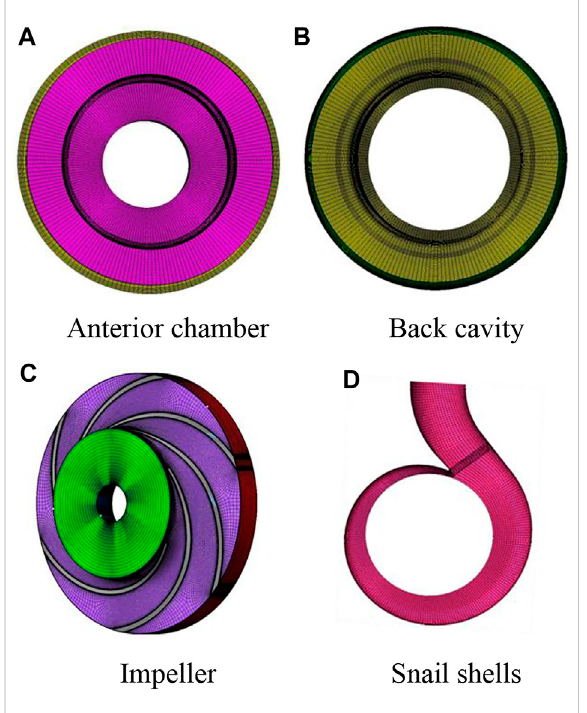
FIGURE 2 Centrifugal pump meshing. (A) Anterior chamber, (B) Back cavity, (C) Impeller, (D) Snail shells